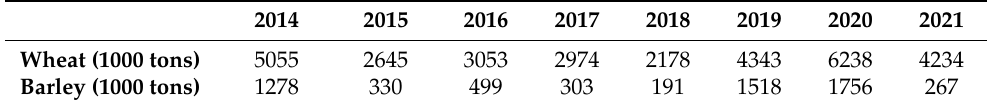
Table 7. Wheat and Barley production in Iraq